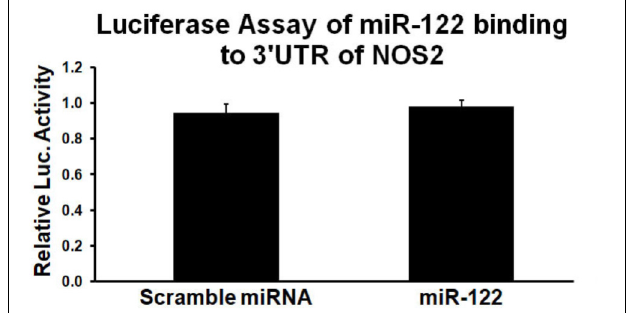
FIGURE 2 | MiR-122 mimic has little effects on luciferase activity of wild type NOS2 3 (cid:48) UTR. Results from triplicate experiments were displayed as a ratio of firefly/Renilla luciferase activity, expressed as a percentage of the values obtained in cells treated only with transfection reagents and NOS2 3 (cid:48) UTR reporter clones. n =